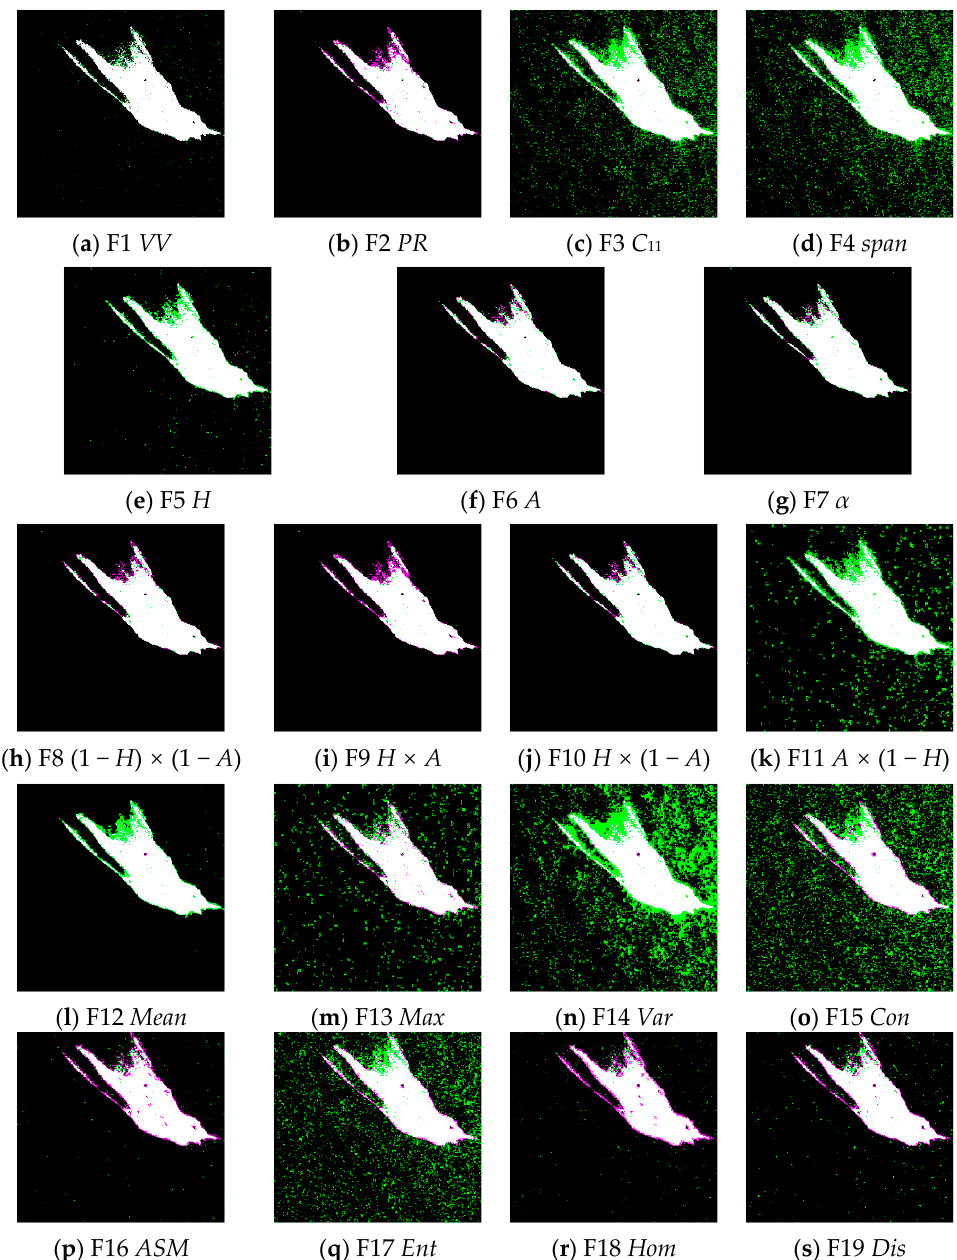
Figure 14. Evaluation results for data a based on K-means algorithm.